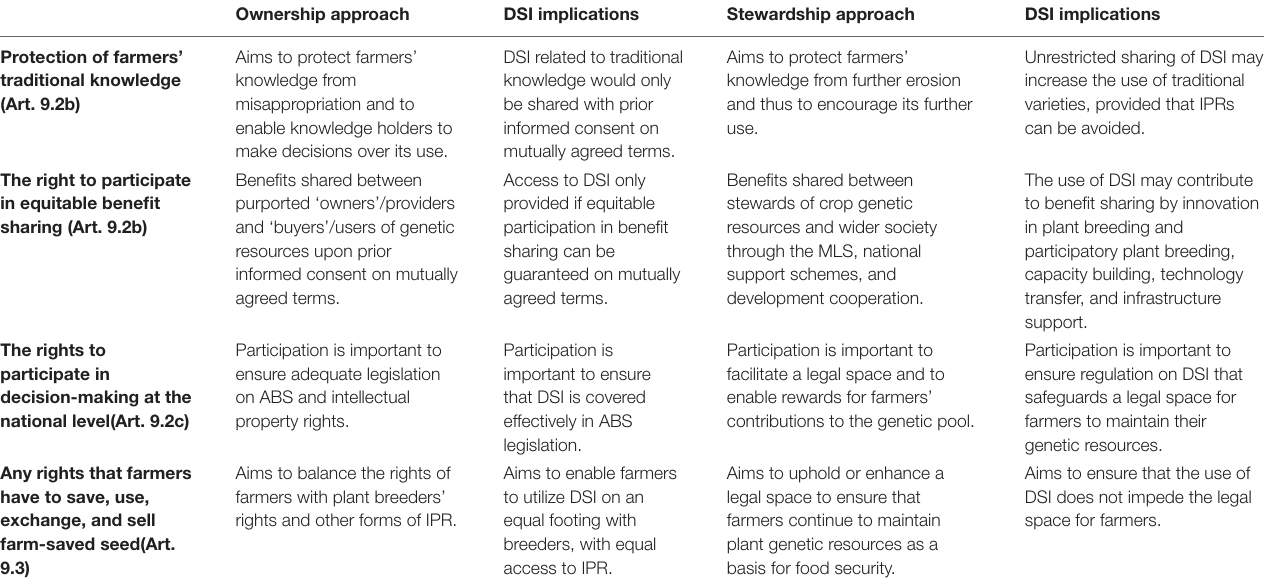
TABLE 2 | Comparing Stewardship and Ownership Approaches for Farmers’ Rights and